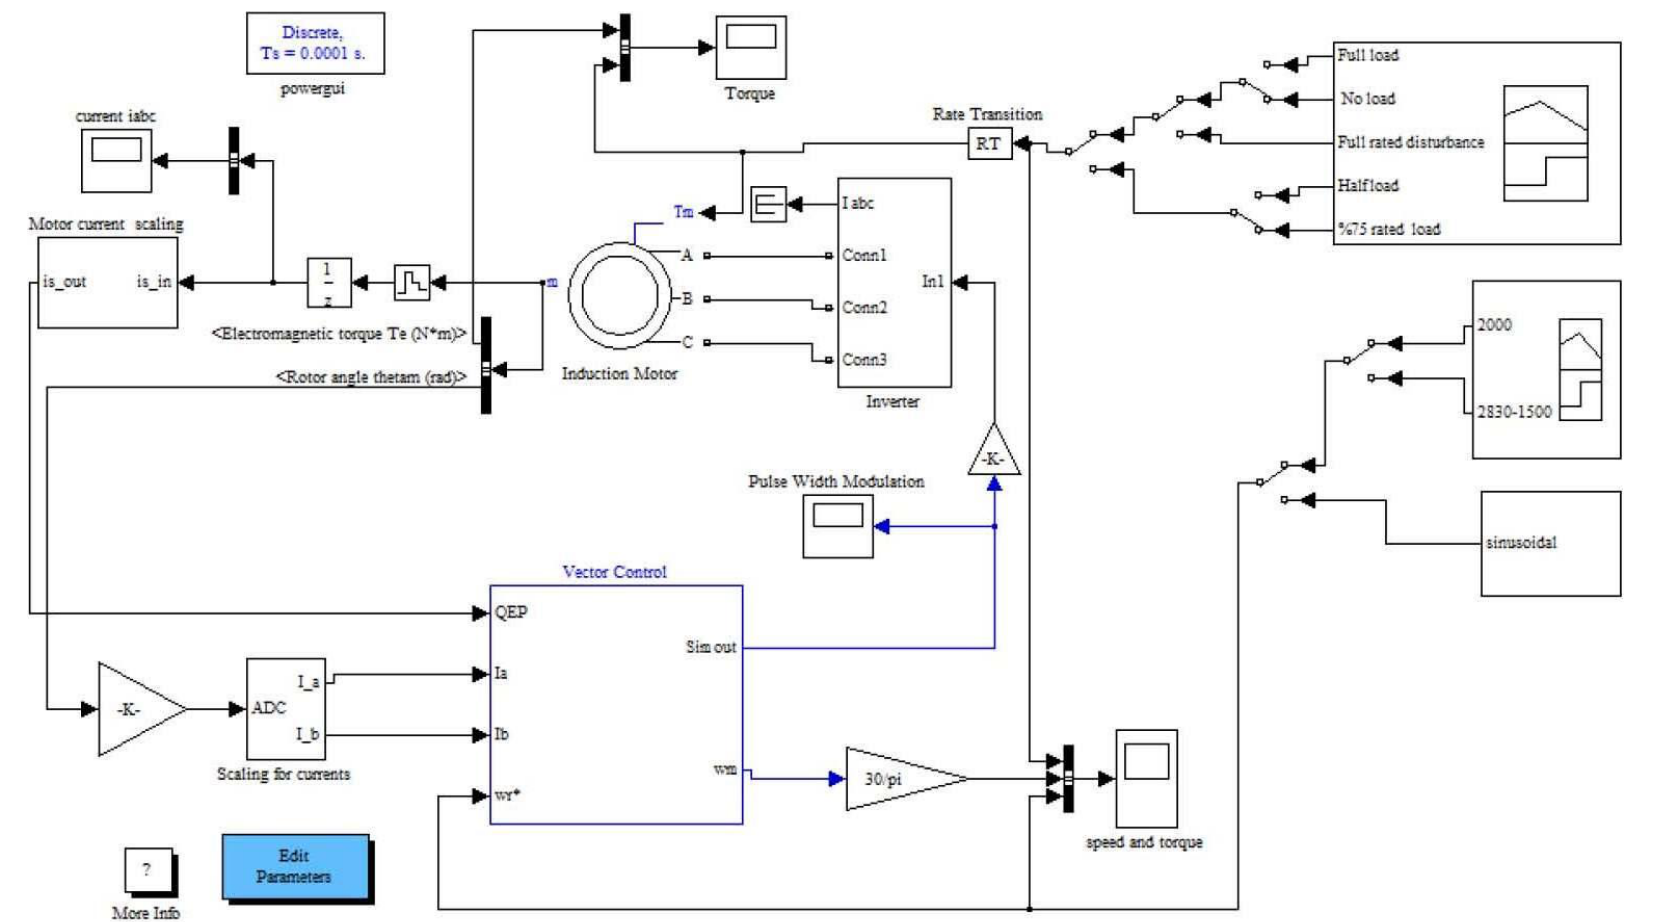
Figure 6. The main Simulink model for the IFOC of an IM